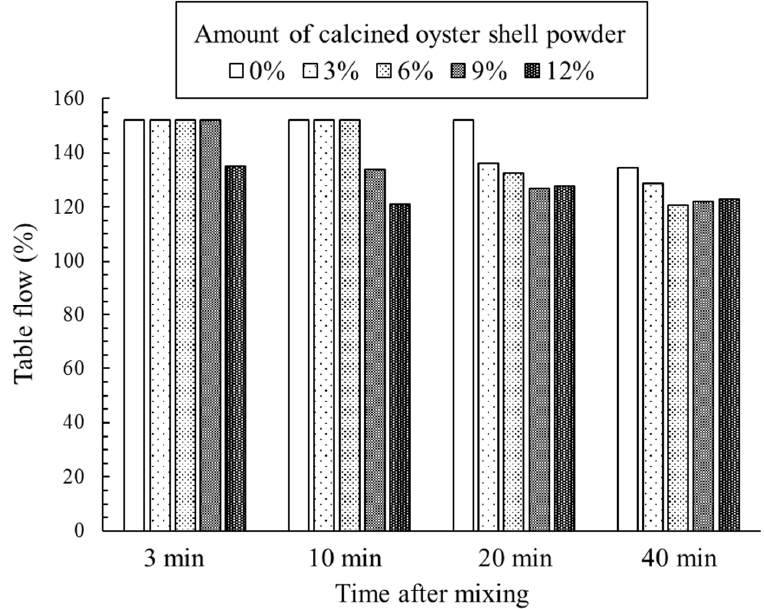
Figure 5. Table flow test results of cement mortar incorporating calcined oyster shell powder.